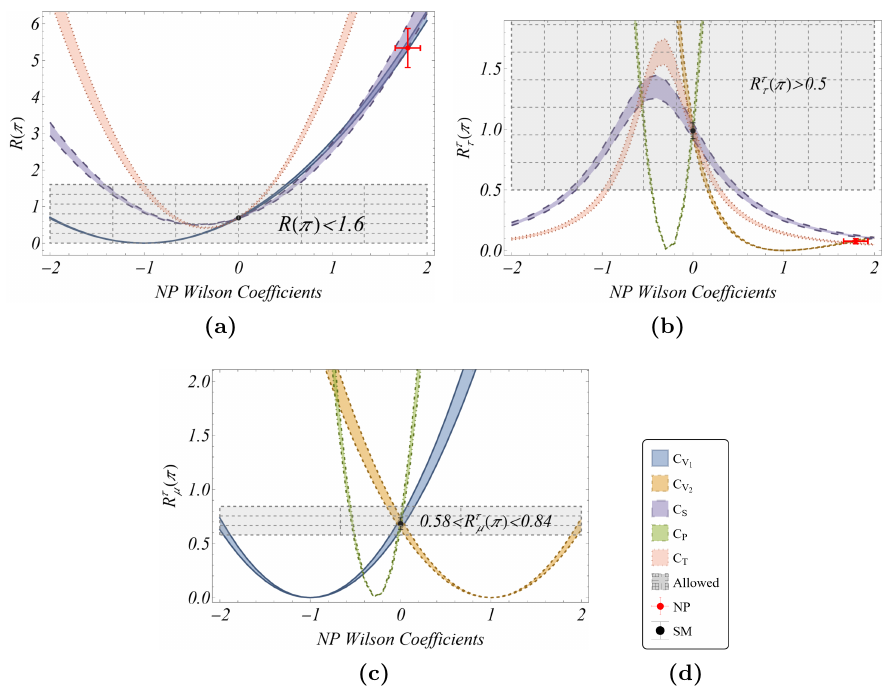
( π ) and R µ ( π ) w.r.t. new WC’s (real), taken Figure 2. Variations of the observables R ( π ) , R τ τ τ one at a time. The grey hatched regions are allowed by the current experimental limits. The exclusion region is derived from the Belle estimate for the upper limit corresponding to BR ( B 0 → π − τ + ν τ ) < 2 . 5 × 10 − 4 at 90% confidence level. The values of the observables corresponding to out NP solutions from fit have also been shown. The corresponding best fit values for the NP WC’s have been provided in the